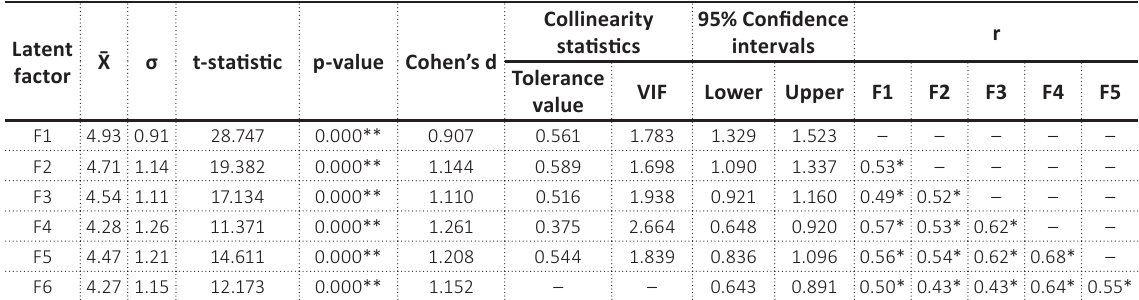
Table 4. SPSS output